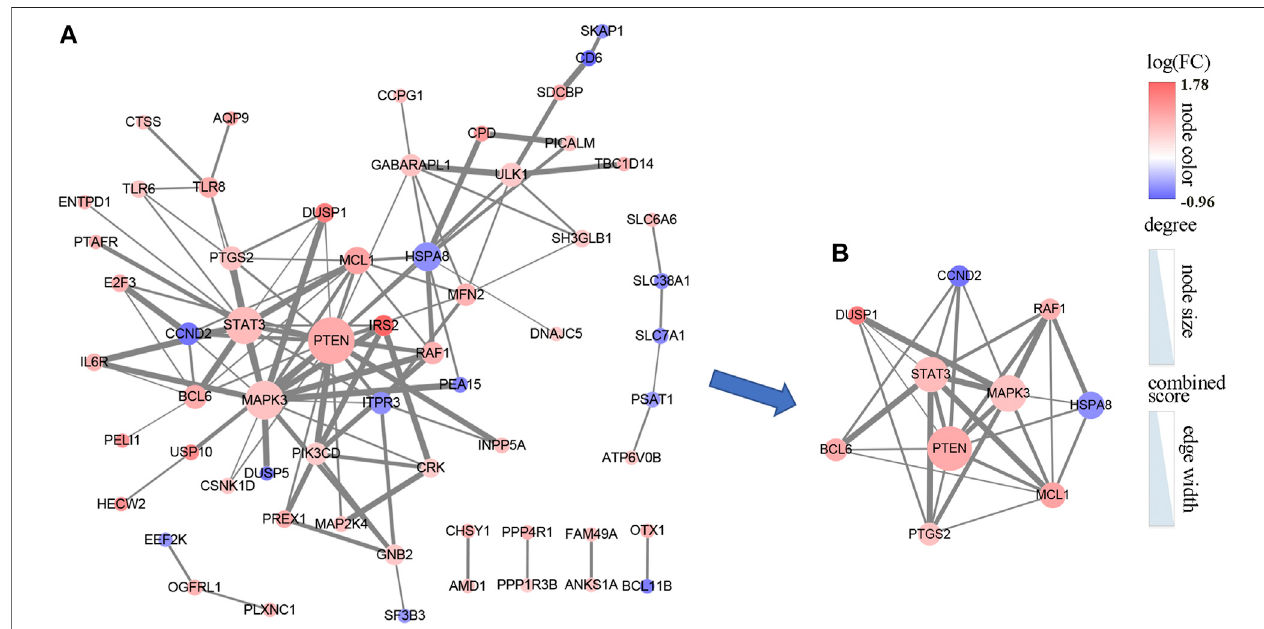
FIGURE 5 | The PPI network of 106 DEmRNAs. (A) The PPI network consists of 61 nodes and 108 edges. (B) The PPI network was analyzed by cytoHubba, and the top 10 points were selected as hub genes. The color of the dots represents the intensity of differential expression of genes; size shows the degree of gene connectivity; width of the line means the strength of interaction between